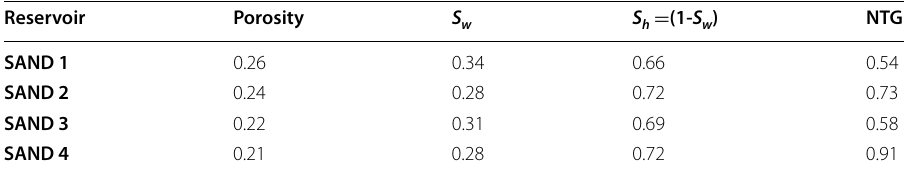
Table 1 Calculated petrophysical parameters for reservoirs in well Jay 1 Reservoir